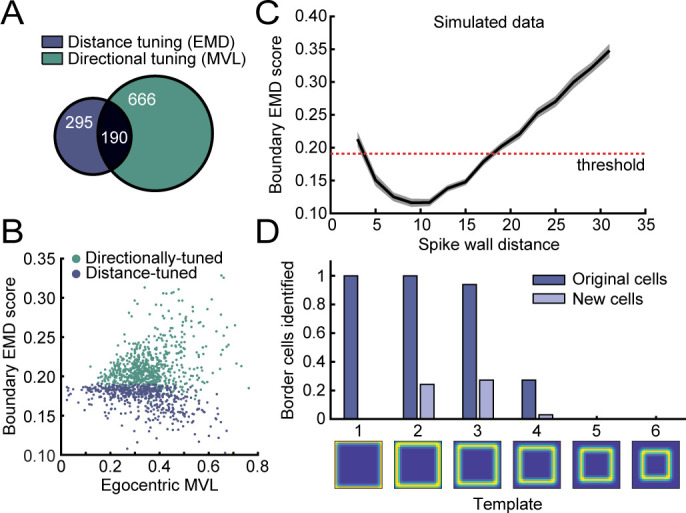
Directional and distance tuning properties of RSC border cells.(A) Venn diagram showing the overlap between cells that display distance tuning (classified using the EMD scores) and cells with egocentric directional tuning to walls (classified using the egocentric boundary MVL). (B) Distribution of MVL values and EMD scores for cells that are significantly tuned to the distance or direction to the boundaries. (C) Simulated EMD scores of rate maps with synthetic spikes at specific distances away from the wall, simulated at 2 cm intervals using all behavioral sessions. Mean across cells (thick line) ± SEM (shaded). (D) EMD classification of RSC border cells with a subset of data and different templates, each with firing fields at increasingly further distances from the wall. Most original cells could be captured using templates with fields up to 12 cm away (template 3), and although higher templates found several additional cells, no major new populations of border cells were found using far-distance templates. This confirms that most border cells in RSC exhibit distance tuning at close wall proximity below the range of 20 cm.